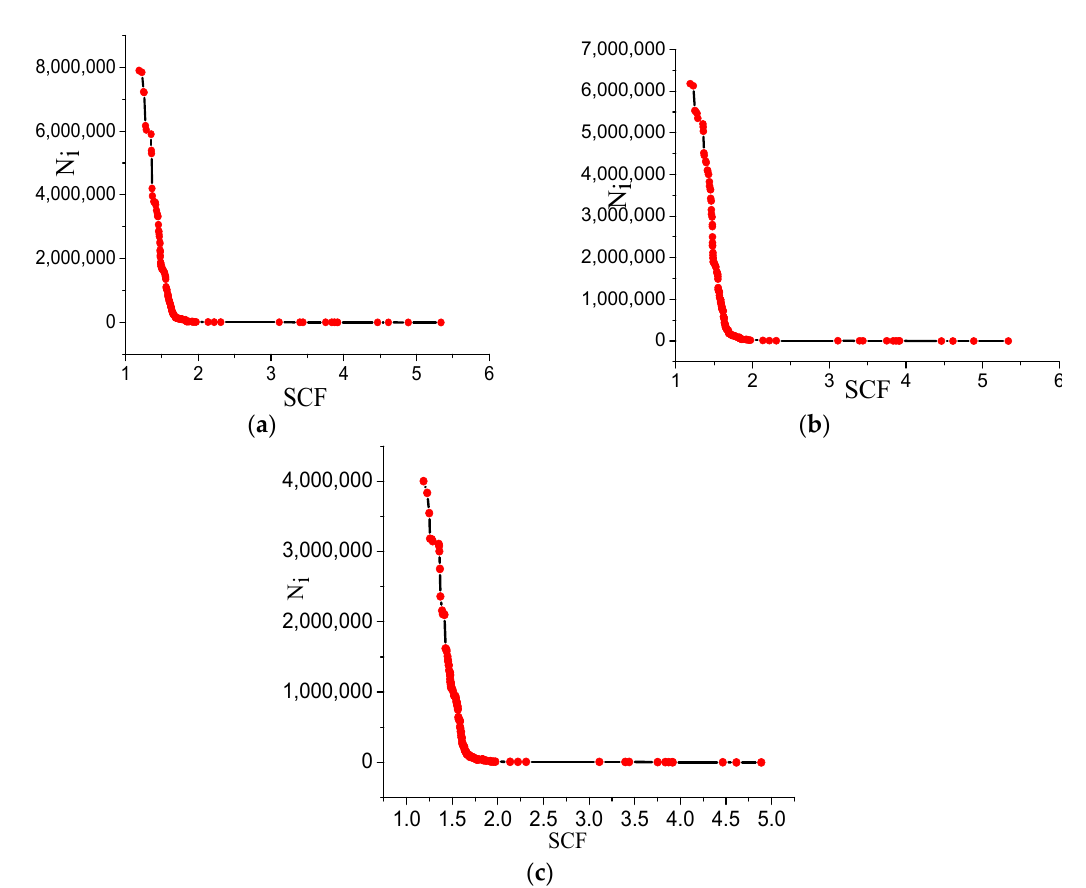
Figure 18. Fatigue life curve of steel strand. ( a ) Δ S = 100 MPa; ( b ) Δ S = 200MPa; ( c ) Δ S = 300 MPa.